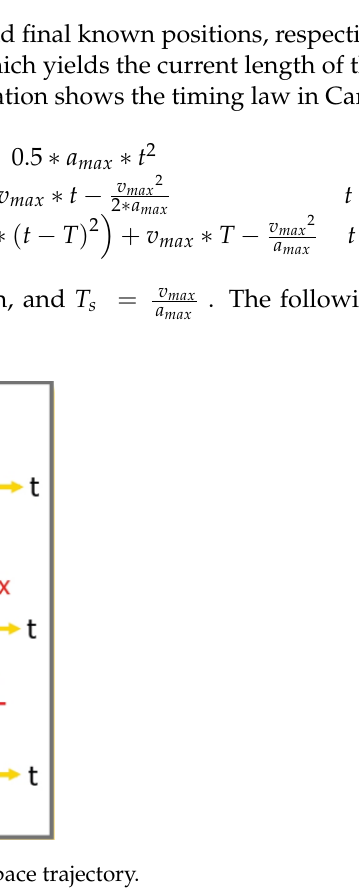
Figure 7. Attractive and repulsive potential field [30].